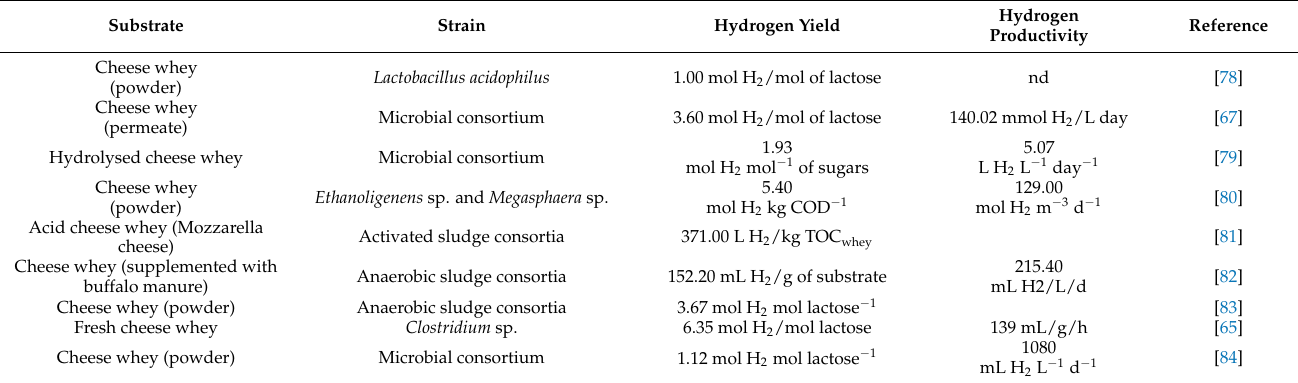
Table 4. Biohydrogen production using cheese whey as a